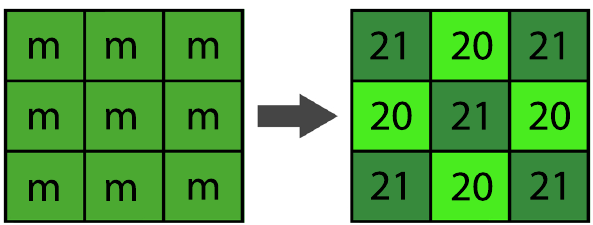
Fig. 3. Reclassification of forested areas labelled as “mixed for- est” (m) to an evenly distribution of deciduous (20) and coniferous (21) forest. The Pixels are alternately classified to coniferous and